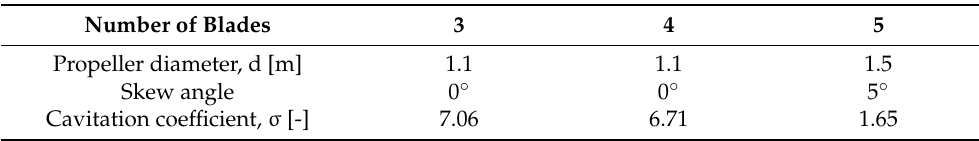
Figure 2. Computational domain, boundary conditions, and hydrophone positions. Table 1. Geometric parameters of the propeller and the working conditions. All propellers were modeled at a constant speed of 300 rpm.